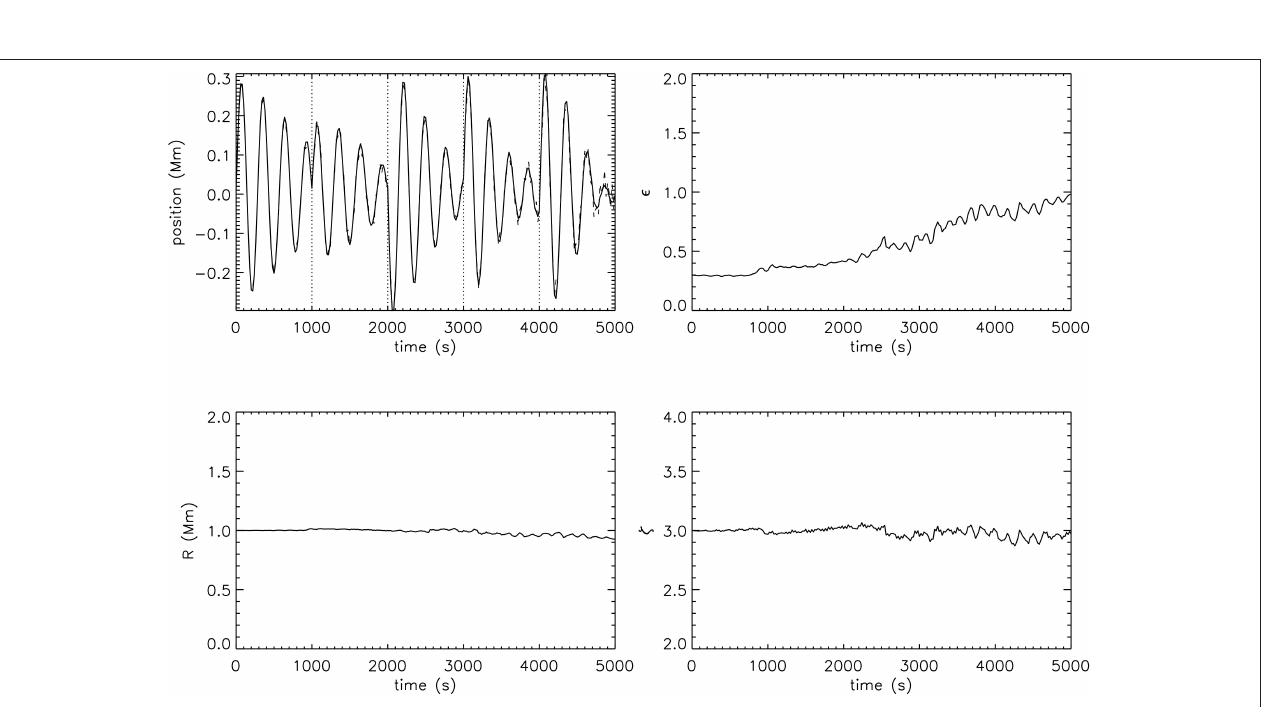
FIGURE 2 | Oscillation of the coronal loop and evolution of the transverse loop density profile parameters taken at the middle of the loop during our numerical simulation; loop position (top left) , normalized inhomogeneous layer width (top right) , loop radius (bottom left) , and density contrast ratio (bottom right) .